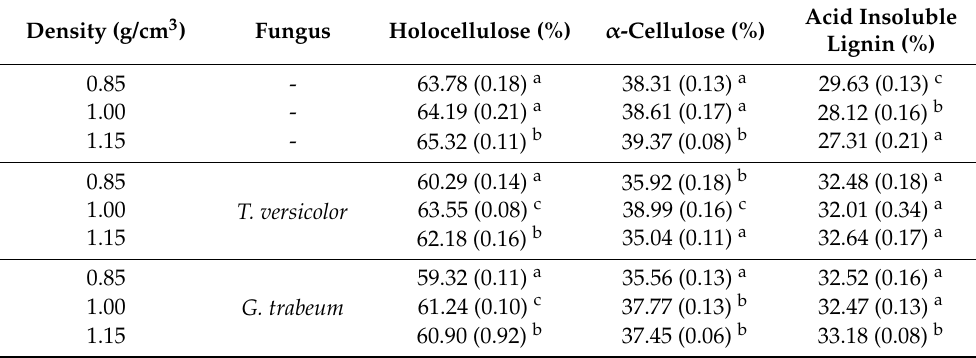
Values in parenthesis are standard deviations. For each parameter, average values with different letters ( a , b , c ) in each column indicate a significant difference at the 0.05 level (analysis of variance (ANOVA), followed by Duncan’s multiple range